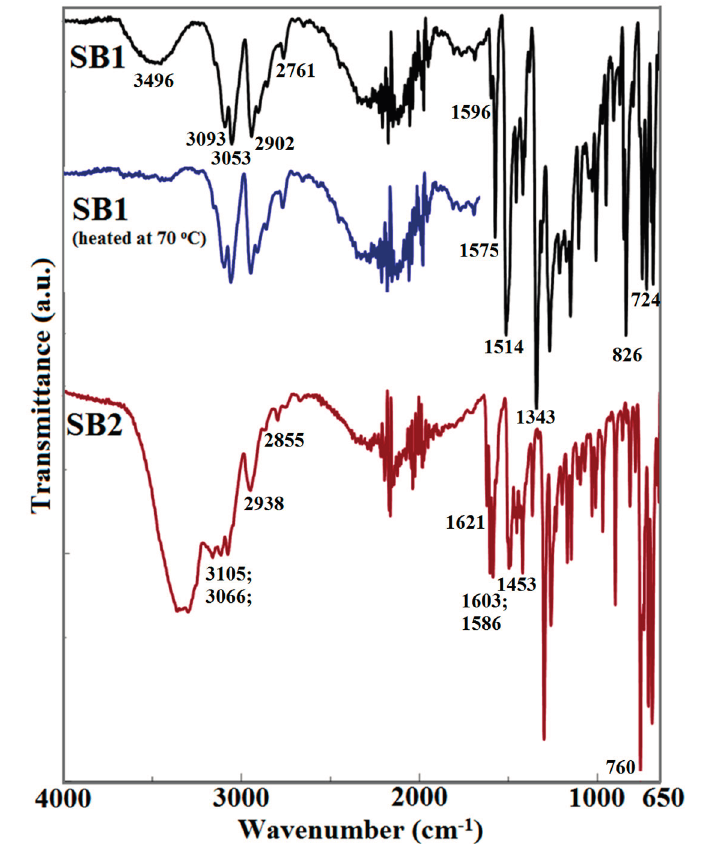
Figure 1. The FTIR spectra of Schiff bases: SB1, SB1 heated at 70 °C and